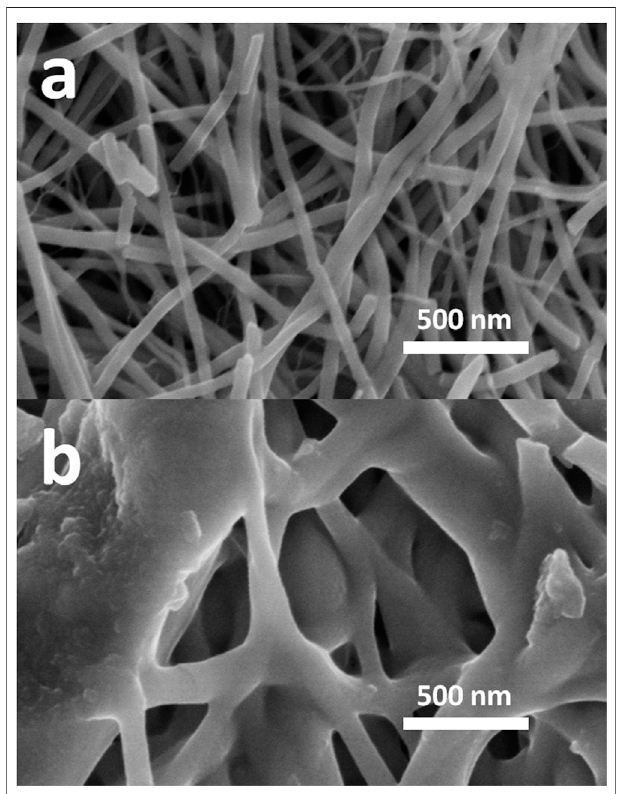
FIGURE 2 | Low-magni fi cation transmission electron microscope images of (A) air-mesoporous silica nano fi ber and (B) mesoporous silica nano fi